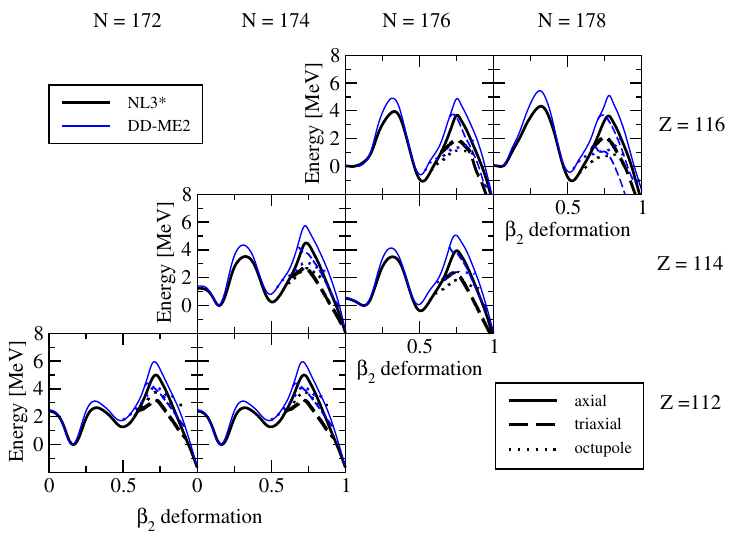
Figure 3. Deformation energy curves for the Z = 112, 114 and 116 nuclei obtained with the NL3* and DD-ME2 parameterizations. Solid lines correspond to axial solutions with reflection symmetry (A), dashed lines to triaxial solutions with reflection symmetry (T), and dotted lines to octupole deformed solutions with axial symmetry (O). Note that the T and O solutions are shown only in the deformation range in which they are lower in energy than the axial solution. From Ref. [16].